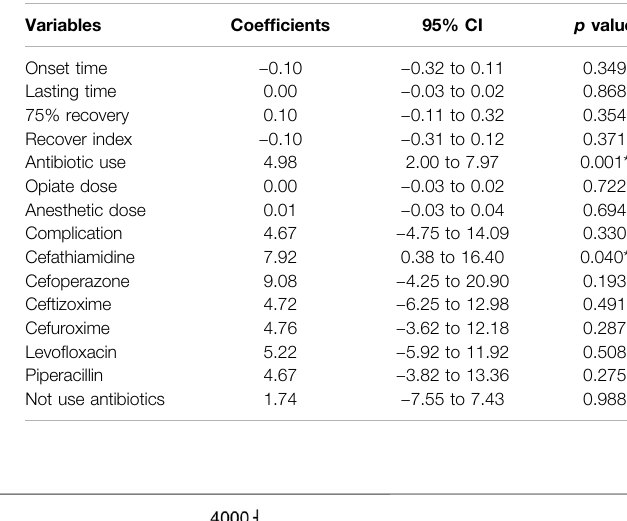
TABLE 3 | Linear regression analysis of the impact of cigarette